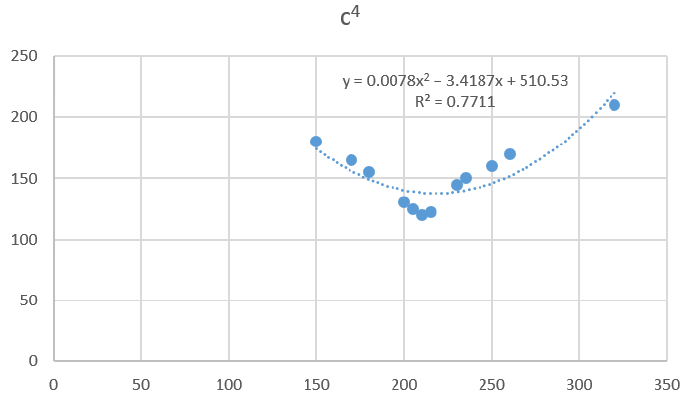
Figure 3. Analytical cost dependency on the size of the stock of the third type.